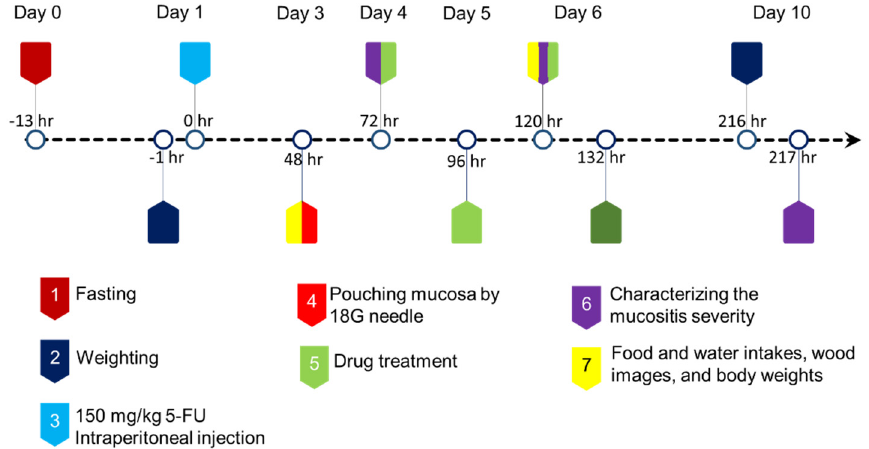
Figure 1. The animal protocol in this study.